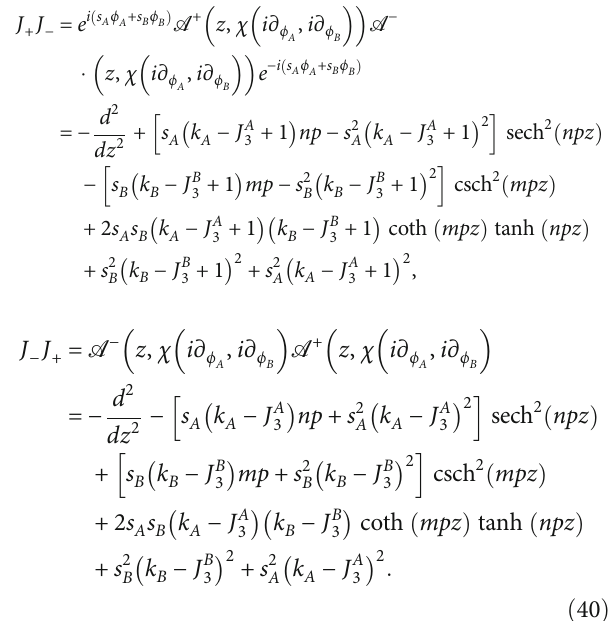
Table 1: The energy eigenvalue E −